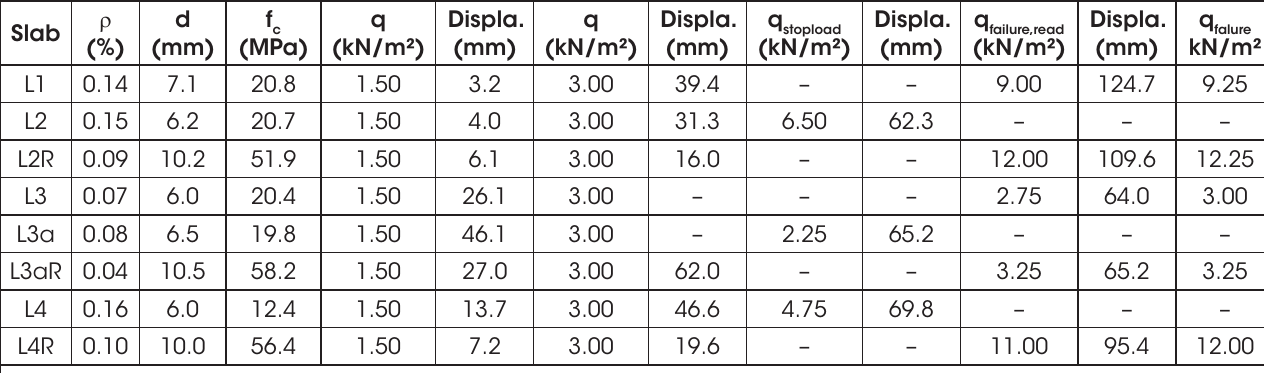
Summary of central load-deflection for all